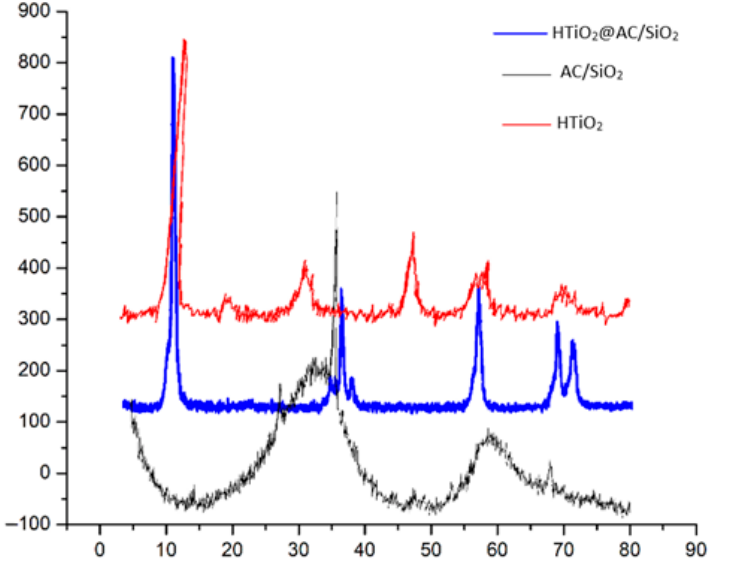
Figure 1. XRD patterns of activated carbon (AC/SiO 2 ), titanium dioxide (HTiO 2 ), and HTiO 2 @AC/SiO 2 composites.